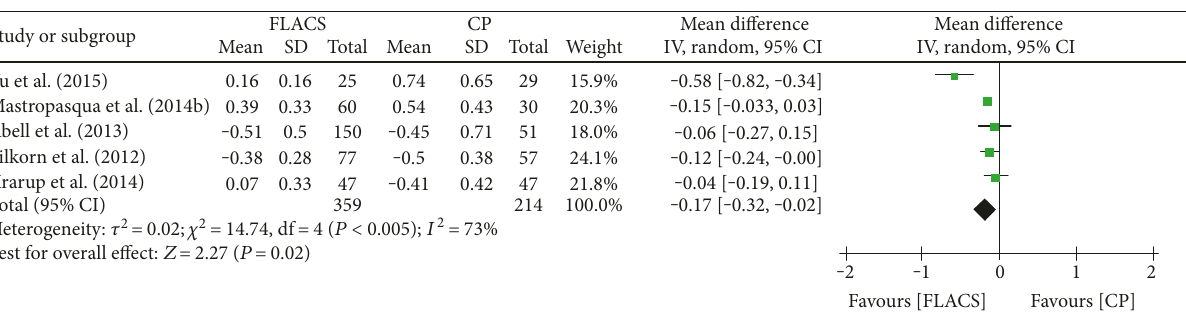
Figure 5: Forest plots displaying the e ff ect of femtosecond laser-assisted cataract surgery (FLACS) versus conventional phacoemulsi fi cation cataract surgery (CPCS) on refractive